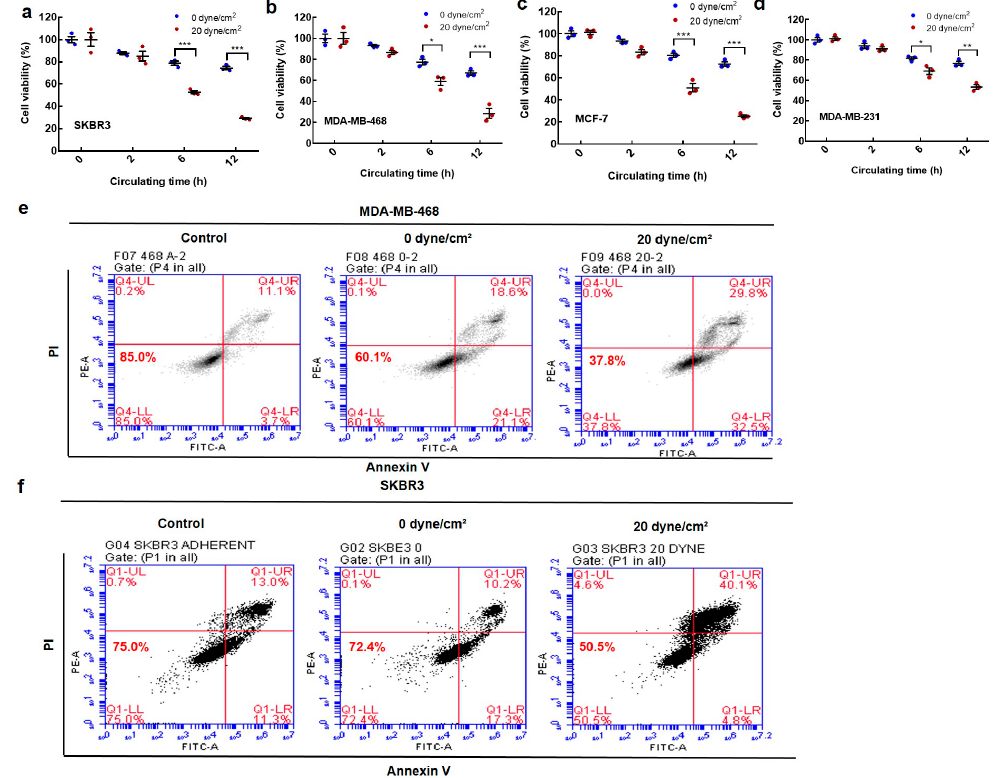
Figure 1. The influence of fluid shear stress on the viability of suspended tumor cells. ( a – d ) The viability of breast cancer cells in suspension. Single-cell suspensions of SKBR3 ( a ), MDA-MB-468 ( b ), MCF-7 ( c ), and MDA-MB-231 ( d ) were circulated under 0 and 20 dyne / cm 2 shear stress for various circulation durations. Cell viability was measured by (3-(4,5-dimethylthiazol-2-yl)-5-(3-carboxymethoxyphenyl)-2-(4-sulfophenyl)-2H-tetrazolium) (MTS) assay and normalized by the data at 0 h under the same treatment. n = 3 independent experiments; ( e , f ) The influence of fluid shear stress on tumor cell survival. Cell apoptosis of MDA-MB-468 ( e ) and SKBR3 ( f ) cells was examined by the Annexin V-Fluorescein isothiocyanate (FITC)/Propidium iodide (PI) assay after circulation under 0 and 20 dynes / cm 2 shear stress for 12 h. n = 2 independent experiments. * p < 0.05; ** p < 0.01; *** p < 0.001.